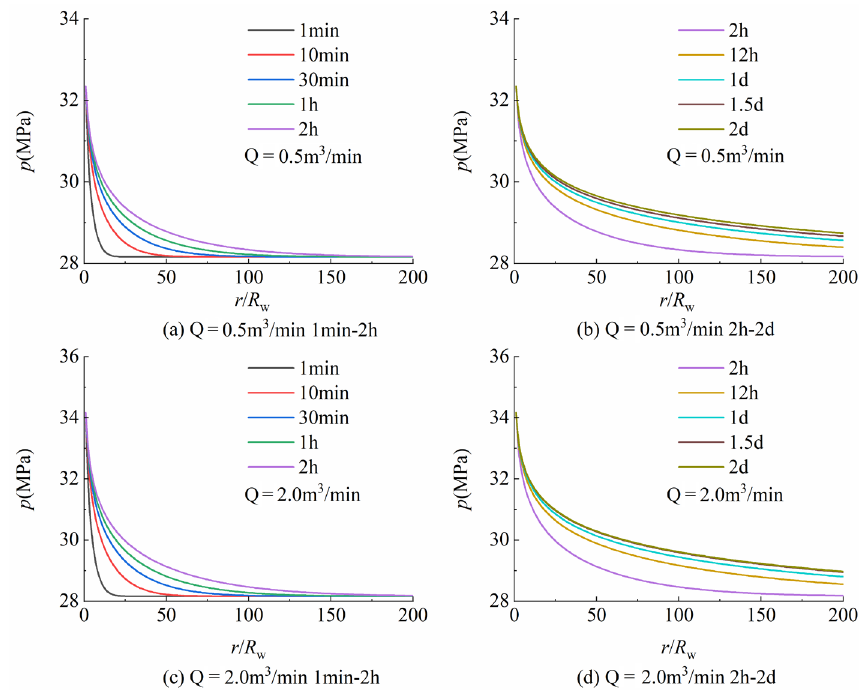
Figure 3. Distribution of pore pressure near well under different injection rate.